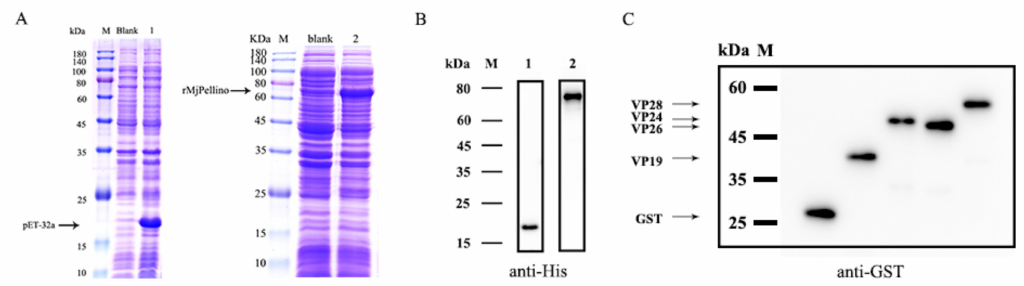
Figure 5. SDS-PAGE analysis of the induction of His-pET32a and rMjPellino protein expression and Western blot analysis of purified His-pET32a, rMjPellino, rVP19, rVP24, rVP26, and rVP28 proteins. ( A ) His-pET32a protein and rMjPellino expression. M, protein molecular standard; blank, total cellular extract from E. coli BL21(DE3) pLysS chemically competent cells before IPTG induction; 1, SDS-PAGE of pET-32a after IPTG induction; 2, SDS-PAGE of rMjPellino after IPTG induction. ( B ) Western blot analysis of pET-32a (lane 1) and rMjPellino (lane 2). ( C ) Western blot analysis of pGEX-4T-1, rVP19, rVP24, rVP26, and rVP28 (from left to